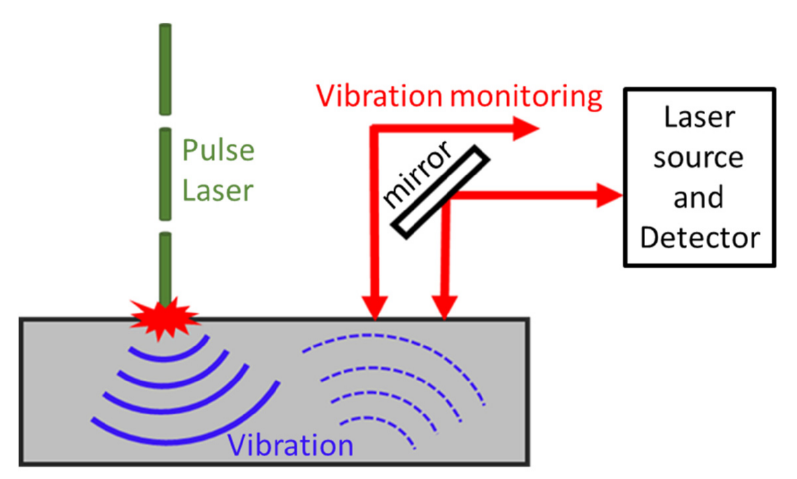
Figure 12. Schematic of laser ultrasonic set-up wave paths from top to bottom of a sample.